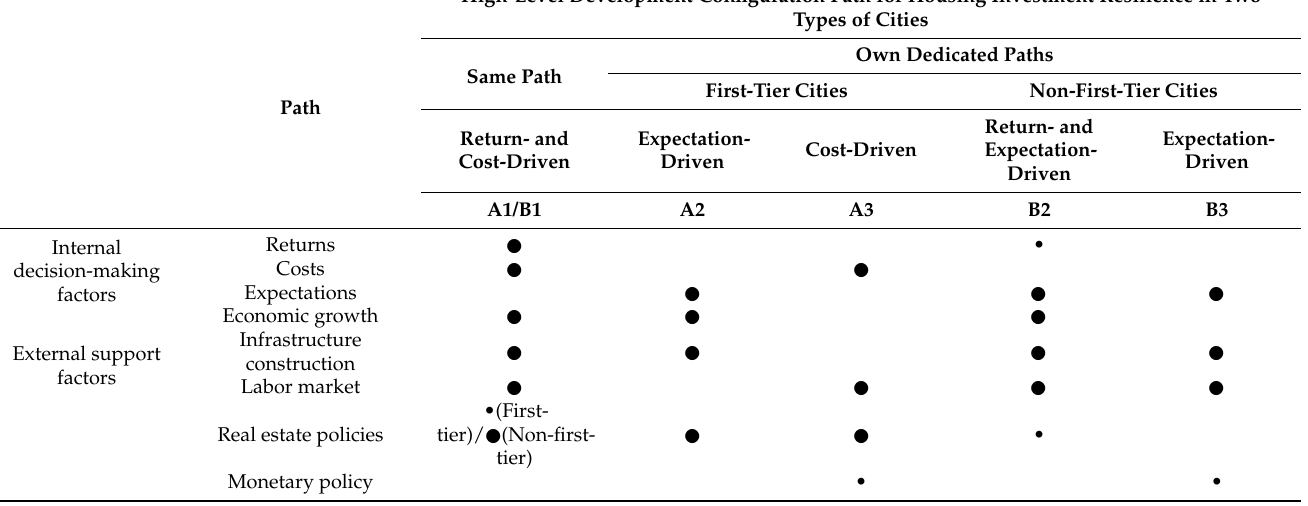
Table 6. Comparative analysis of grouping paths in first-tier and non-first-tier cities. High-Level Development Configuration Path for Housing Investment Resilience in Two Types of Cities Own Dedicated Paths Same Path First-Tier Cities Non-First-Tier Cities Path Return- and Return- and Expectation- Expectation- Cost-Driven Expectation- Cost-Driven Driven Driven Driven A1/B1 A2 A3 B2